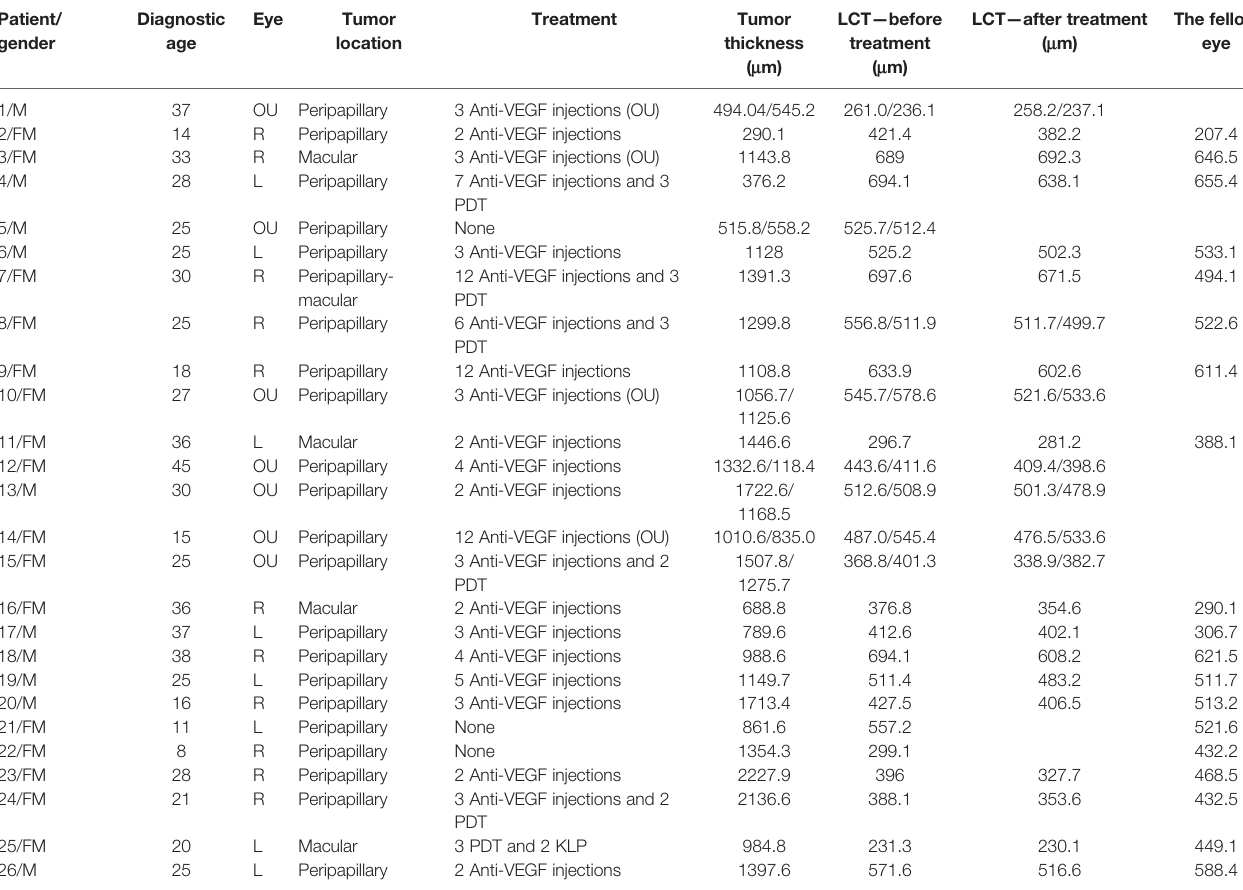
TABLE 1 | Demographic and clinical characteristics of patients with choroidal osteoma